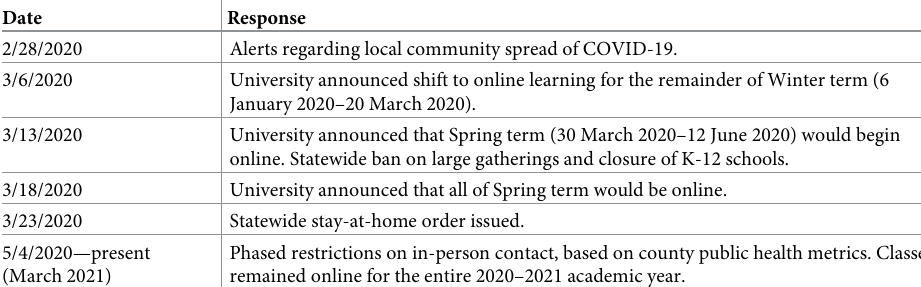
Table 1. Timeline of local response to the